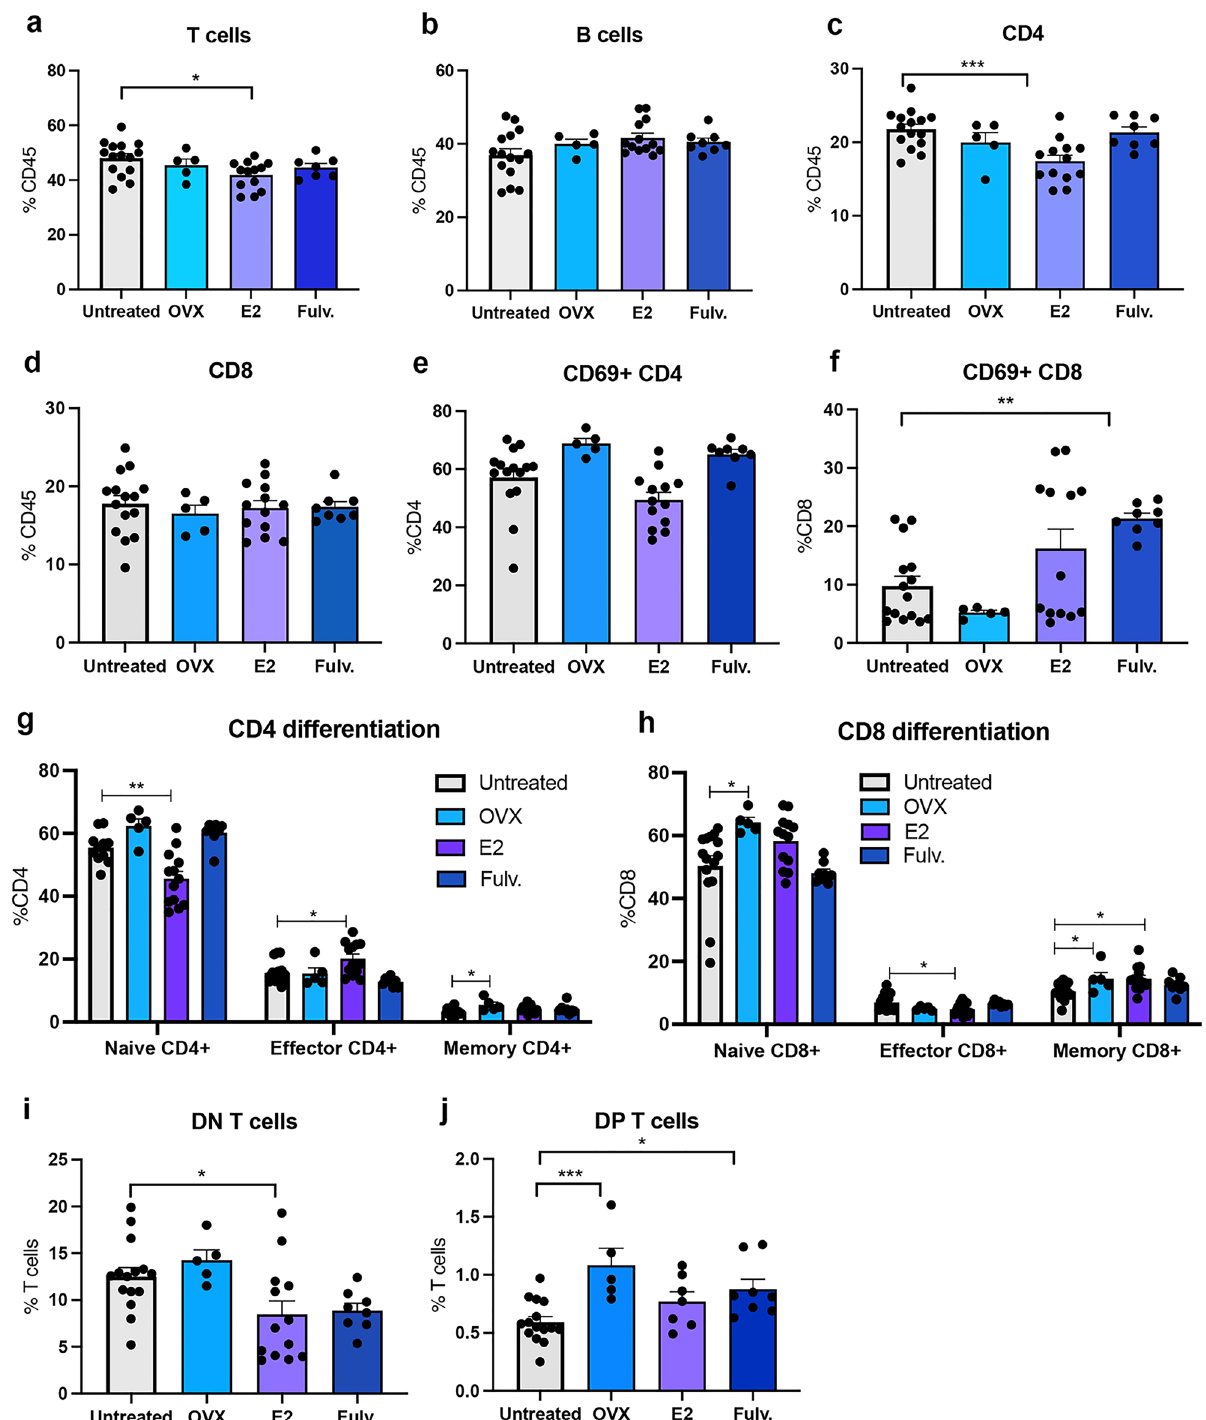
Figure 4. Effects of estrogen, oophorectomy and fulvestrant on the mammary lymph node immune cells. Mice were either untreated, ovariectomised (Ooph) or treated for 6 weeks with estrogen (E2) or Fulvestrant (Fulv). ( a ) T cells, ( b ) B cells, ( c ) CD4 + T helper cells, ( d ) CD8 + cytotoxic T cells, ( e ) Activated CD4 + T cells, ( f ) activated CD8 + T cells, ( g ) CD4 + differentiation status, ( h ) CD8 + differentiation status, ( i ) CD4- CD8- T cells, ( j ) CD4 + CD8 + T cells. Results are expressed percentage of immune cells (mean ± SEM). n = 7–21 mice/group. Data was analysed using a Turkey multiple comparisons one-way ANOVA if confirmed Gaussian distribution, or Kruskal–Wallis multiple comparisons 1-way ANOVA if non-Gaussian. Statistically significant results are denoted with *p < 0.05, **p < 0.01, ***p <